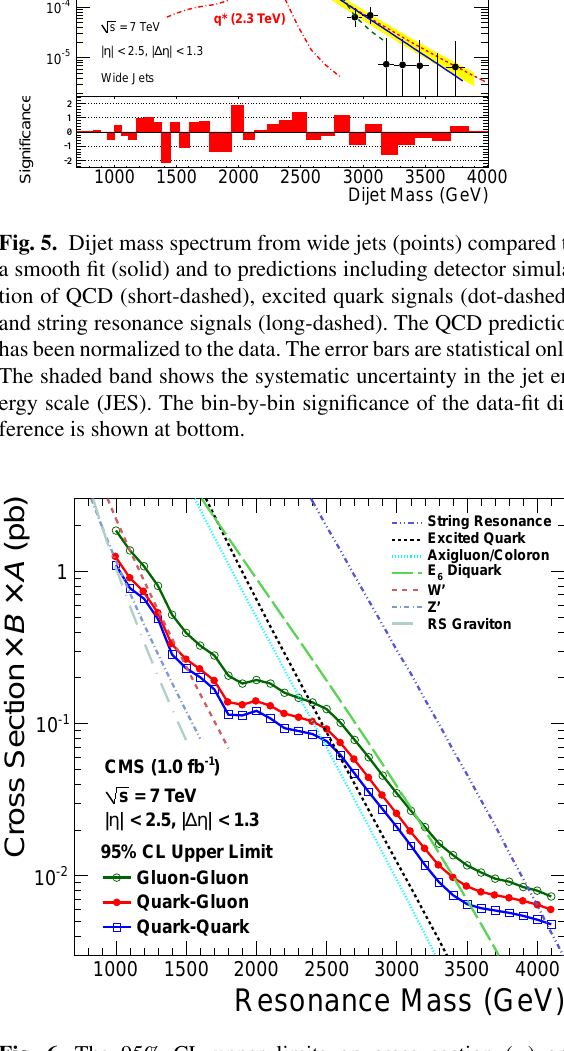
Fig. 6. The 95% CL upper limits on cross section ( σ ) and branching ratio ( B ) and acceptance ( A ), for dijet resonances of type gluon-gluon (open circles), quark-gluon (solid circles), and